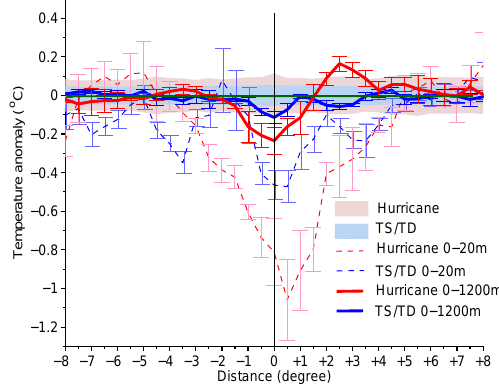
Figure 3. The 0–3-day averaged temperature change as function of distance across the cyclone center for hurricanes (red) and TS/TD (blue), in TC track coordinates. The values are smoothed using a three-point (1.5 ◦ ) moving filter. Light blue shading shows the 90% confidence interval of background noise based on null-hypothesis analyses for TS/TD, and the light pink shading is for hurricanes. Surface temperature anomalies are presented as the thin curves, and the thick curves show 0–1200m averaged temperature changes. The error bars are 1 SD, which is calculated as follows: 90% percent of pairs are randomly selected, and then we calculate the thermal anomalies of these pairs. This process is repeated 200 times, so 200 samples of thermal anomalies are obtained, and the SD is calculated from thermal anomalies of these 200